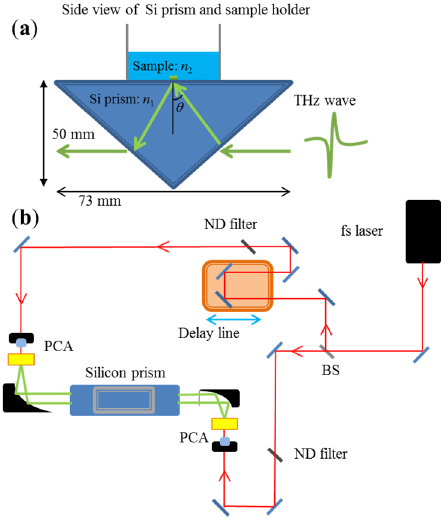
Figure 1. ( a ) Path of the propagating THz wave inside the Si prism. ( b ) Image of the measurement system using a typical THz ‐ TDS system.